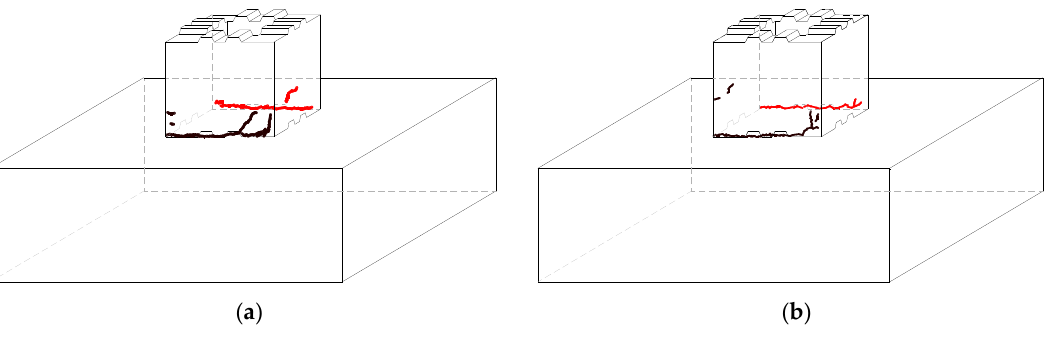
Figure 7. Crack pattern. ( a ) S1. ( b ) S2.